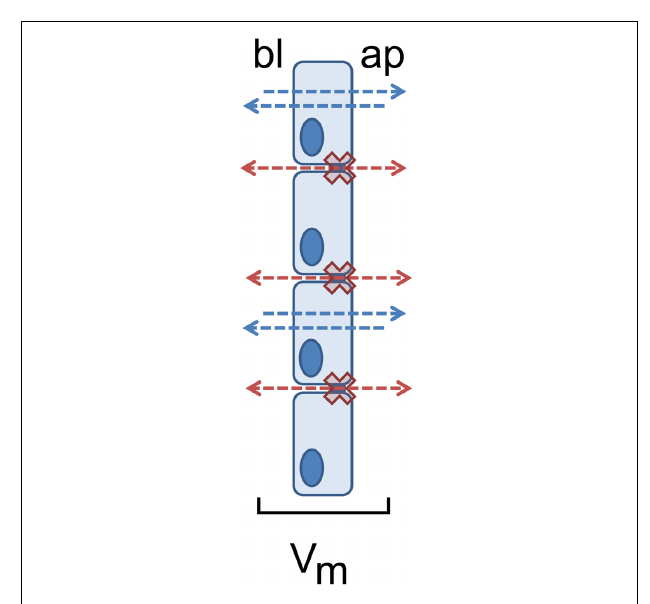
FIGURE 2 | Restricted paracellular permeability as a prerequisite for pleural transmesothelial potential. Transport routes are indicated as blue (transcellular) and red (paracellular) arrows between apical (ap) and basolateral (bl) compartments. The paracellular barrier is indicated as red